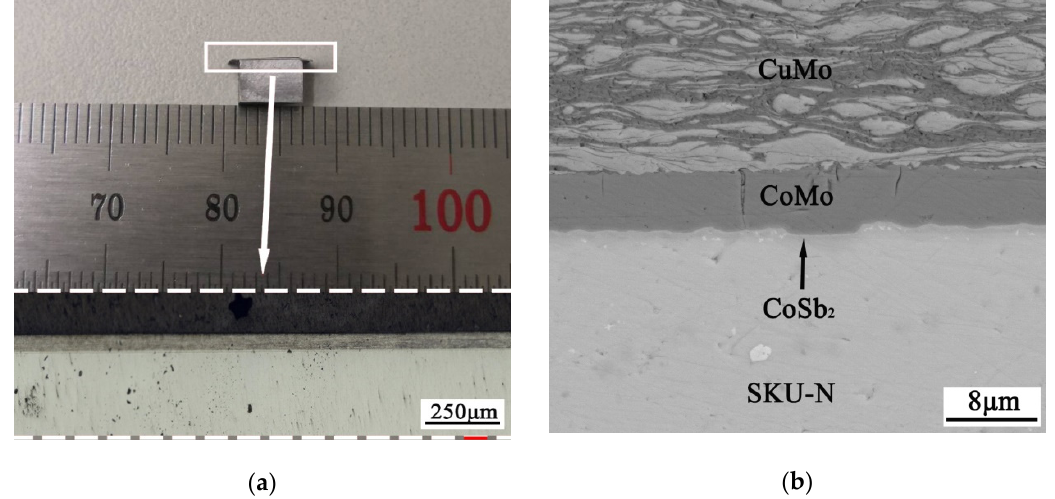
Figure 6. ( a ) The diffusion bonded joint between the skutterudite compound and the Cu-Mo electrode. ( b ) The BSE image of the cross-section of the joint. A reaction layer (CoSb 2 ) of 2–3 μ m forms between the skutterudite compound and the Co-Mo layer after the diffusion bonding process.